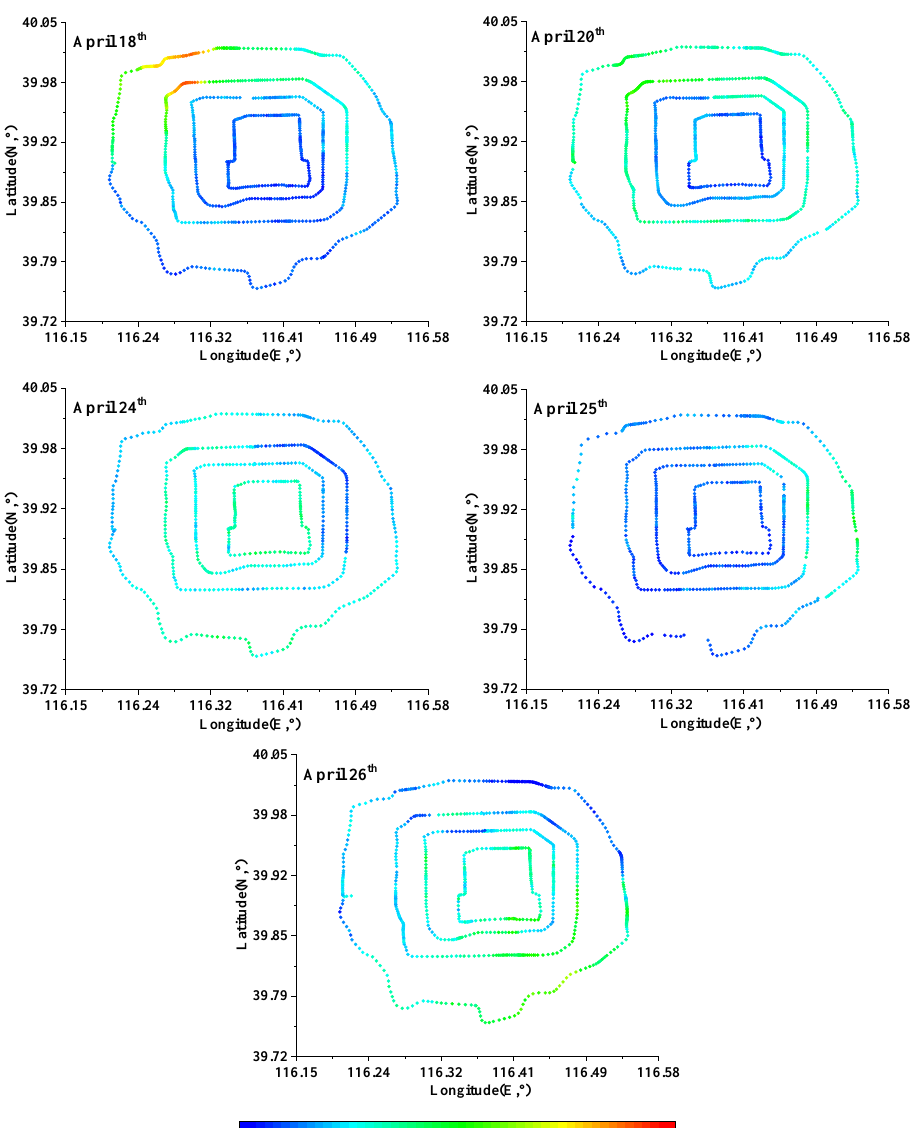
Figure 6. NO 2 VCD distribution of Beijing’s ring roads on April 18th, 20th, 24th, 25th, and 26th. From outside to inside, the ring roads are the fifth ring, fourth ring, third ring, and second